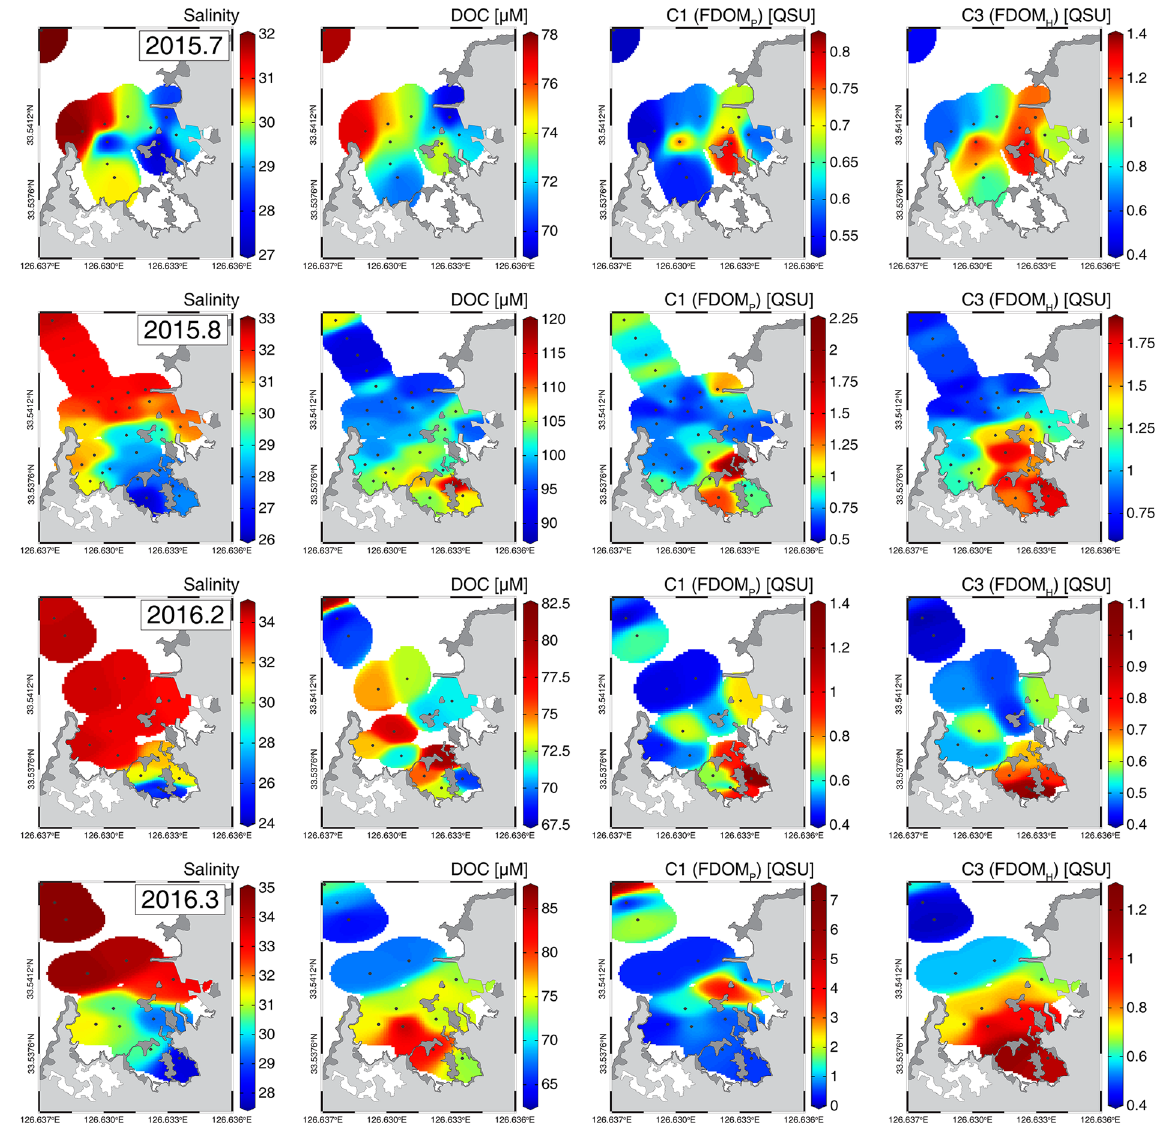
Figure 2. Distributions of salinity, DOC, FDOM P , and FDOM H in the surface water in Jochun Bay. The contour plots were created using Ocean Data View software version 4.7.10. (https://odv.awi.de) and the background maps were drawn using Adobe Illustrator CC software version 2015.0.1.